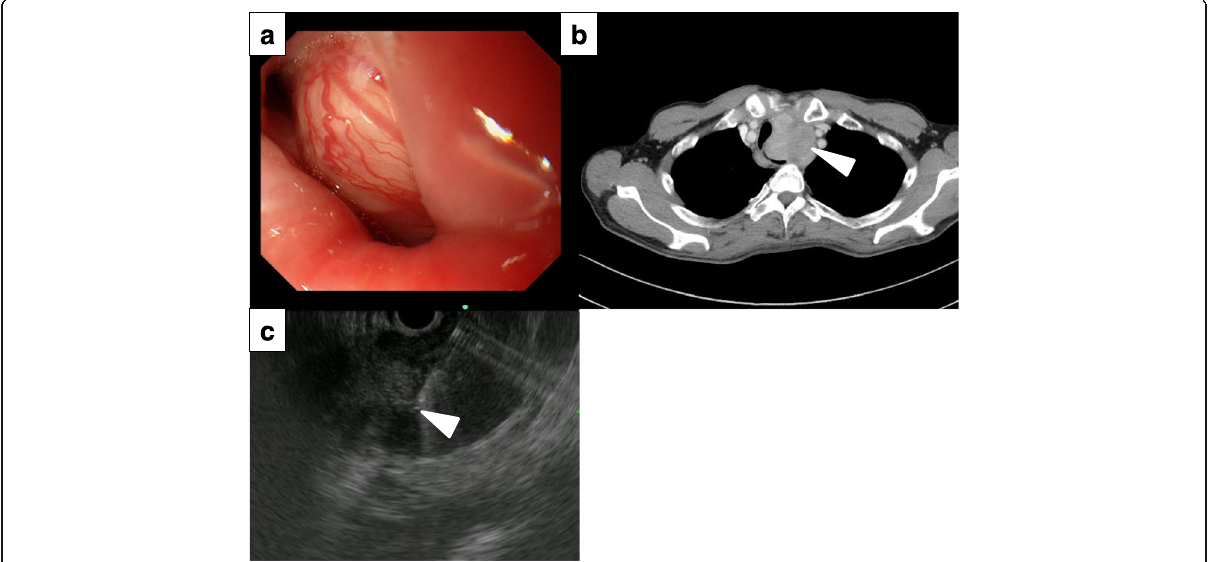
Fig. 1 The examination image before the operation. a Endoscopy revealed an approximately 5.0 cm esophageal submucosal tumor, which was located 25 cm from the incisors. It occupied the majority of the esophageal lumen. b Computed tomography revealed a large isodense tumor of the esophageal wall in the upper mediastinal space ( white arrow ). c Endoscopic ultrasonography showed a large tumor ( white arrow ) of low echogenicity in the submucosa